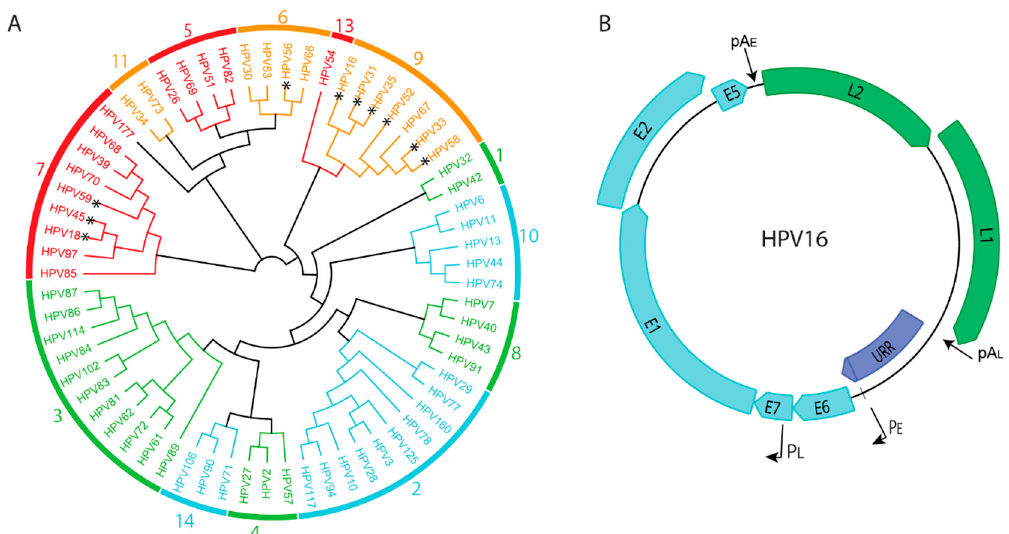
Figure 1. ( A ). Phylogenetic tree derived from the E7 protein sequences of human Alphapapillomaviruses. High-risk viruses are shown in red/orange and low-risk viruses in green/blue. Viral species are shown on the perimeter of the tree. Those viruses that have been found to be frequently integrated are indicated with an asterisk * (Viral Integration site database. https://bioinfo.uth.edu/VISDB ; accessed on 10 August 2021). ( B ). Map of the HPV16 genome. Early genes are shown in cyan and late genes in green. The Upstream Regulatory Region, URR, is shown in purple. Also indicated are the early and late viral promoters, PE and PL, and the early and late polyadenylation signals, pAE and pAL.